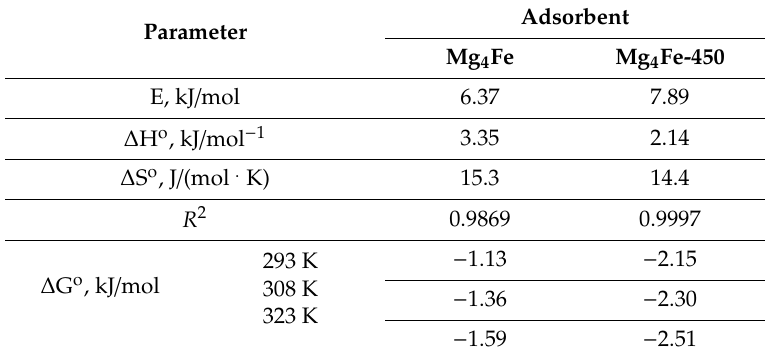
Figure 10. Van ’t Hoff plot of MoO 42− adsorption onto the studied materials. Table 5. Thermodynamic parameters for Mo(VI) adsorption onto Mg 4 Fe and Mg 4 Fe-450.